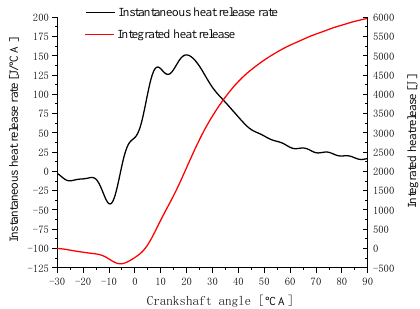
Figure 21. Heat release rate in the original four-stroke mode at 4200 rpm, 92 kW. A comparison of the performance data at rated operation for the poppet-valve two- stroke working mode and the original four-stroke mode is shown in Table 15. It can be seen from the comparative test data that the two-stroke working mode is able to achieve the same effective power output at 2500 rpm as that achieved by the four-stroke mode at 4200 rpm, and the peak pressure in-cylinder is basically the same level. With respect to the exhaust temperature, since a large amount of fresh air is discharged along with the exhaust gas in the previous cycle during the scavenging process of the two-stroke diesel engine, and there is a flow of fresh air directly into the exhaust pipe, the exhaust temper- ature at the rated point of the two-stroke operating mode is much lower than that of the four-stroke mode. In the table, the fuel consumption rate of the two-stroke rated point is better than that of the four-stroke working mode, mainly because the single-cylinder test bench uses an external compressor to supply air, and the power consumption of the scav- enging loss and the scavenging pump loss are not considered. In addition, with the im- proved degree of engine strengthening, the heat transfer loss and air exchange loss of the engine increase synchronously, and under the same effective power output condition, in the four-stroke working mode, the speed of the piston and the crankshaft is much higher than that in the two-stroke mode, resulting in a substantial increase in frictional losses; therefore, there is no longer a thermal efficiency advantage. 4. Conclusions In this work, a 3D combustion simulation model was built, in which the spray sub- model WAVE and the heat release sub-model ECFM-3Z were chosen and calibrated using test data acquired from a constant volume chamber test system and a single-cylinder en- gine test bench. Then, the combustion performance of the three different combustion chambers and three different spray angle schemes was compared and analyzed using both simulation and the engine test bench. The following conclusions were drawn: